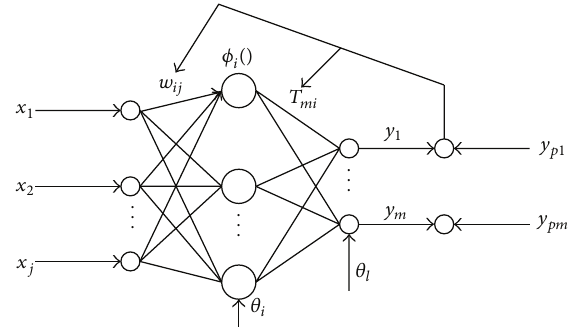
Figure 8: Structure of BP neural